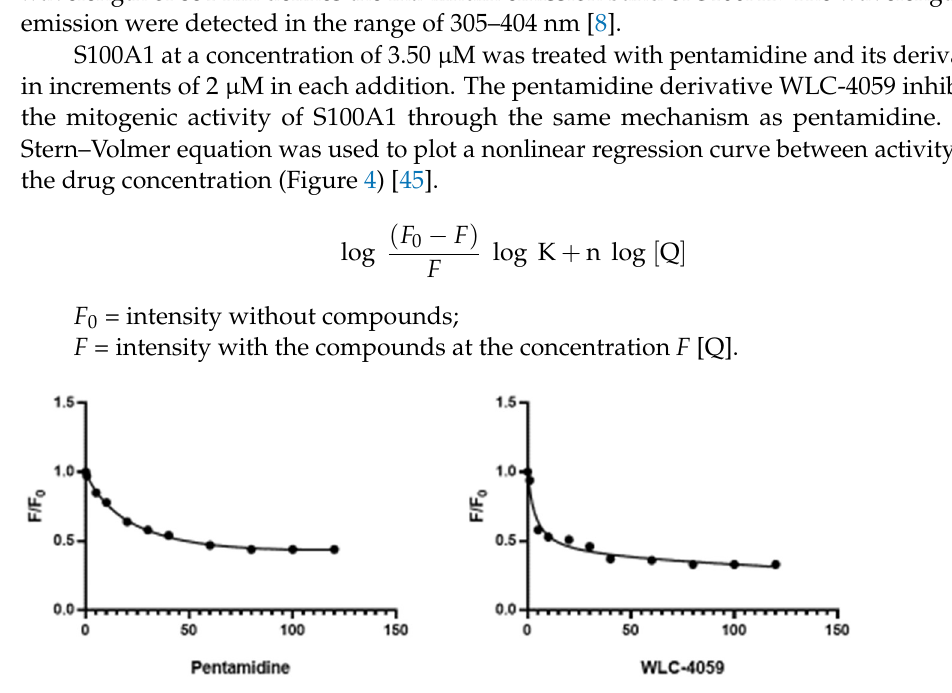
Figure 4. Nonlinear regression curve of S100A1 with pentamidine and WLC-4059.